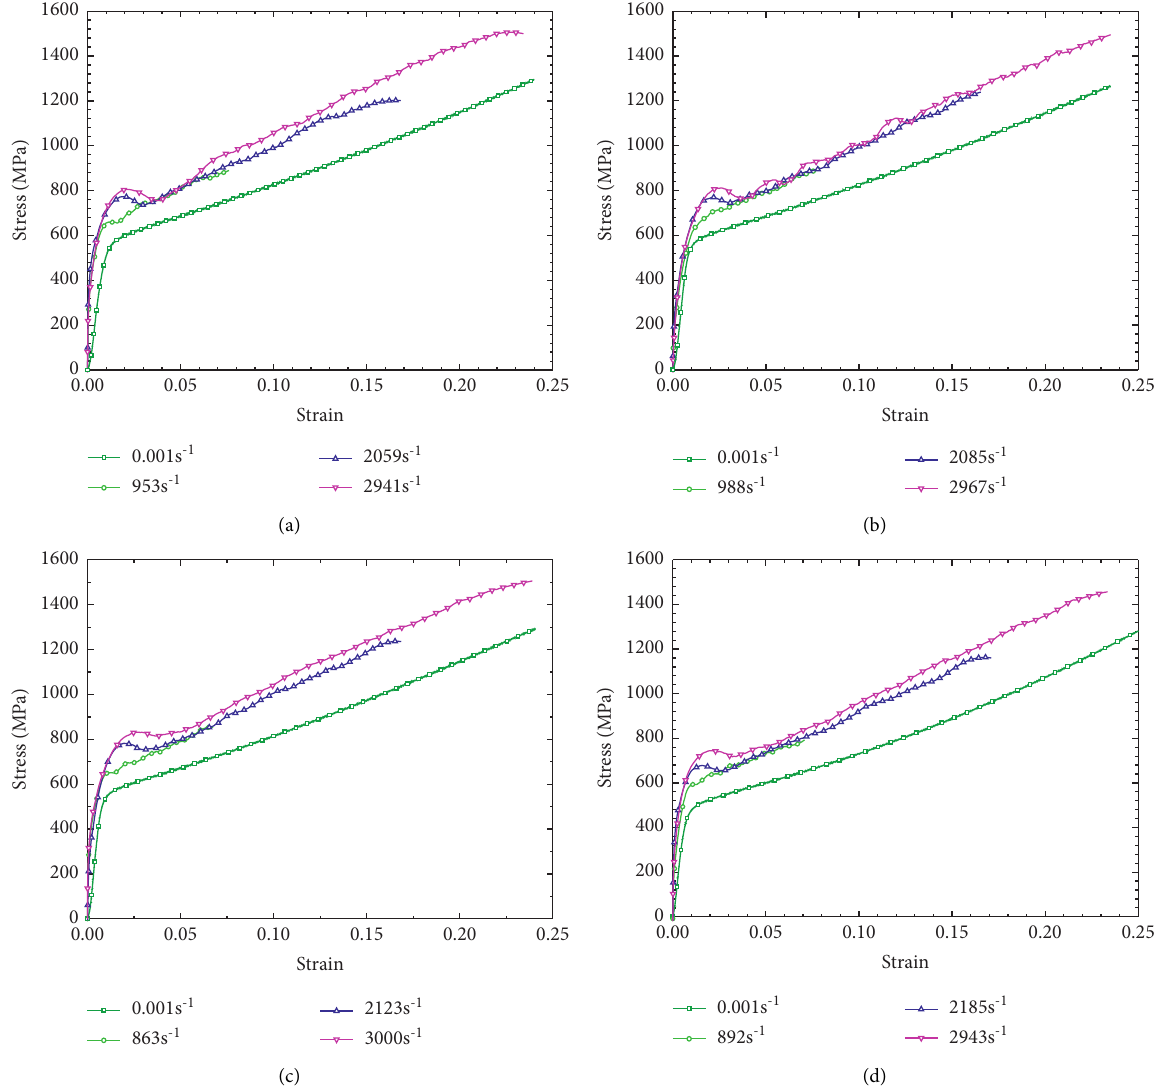
Figure 6: Quasistatic and dynamic compressive stress-strain curves of specimens with four kinds of process parameters. (a) 350mm/s, (b) 650mm/s, (c) 950mm/s, (d)